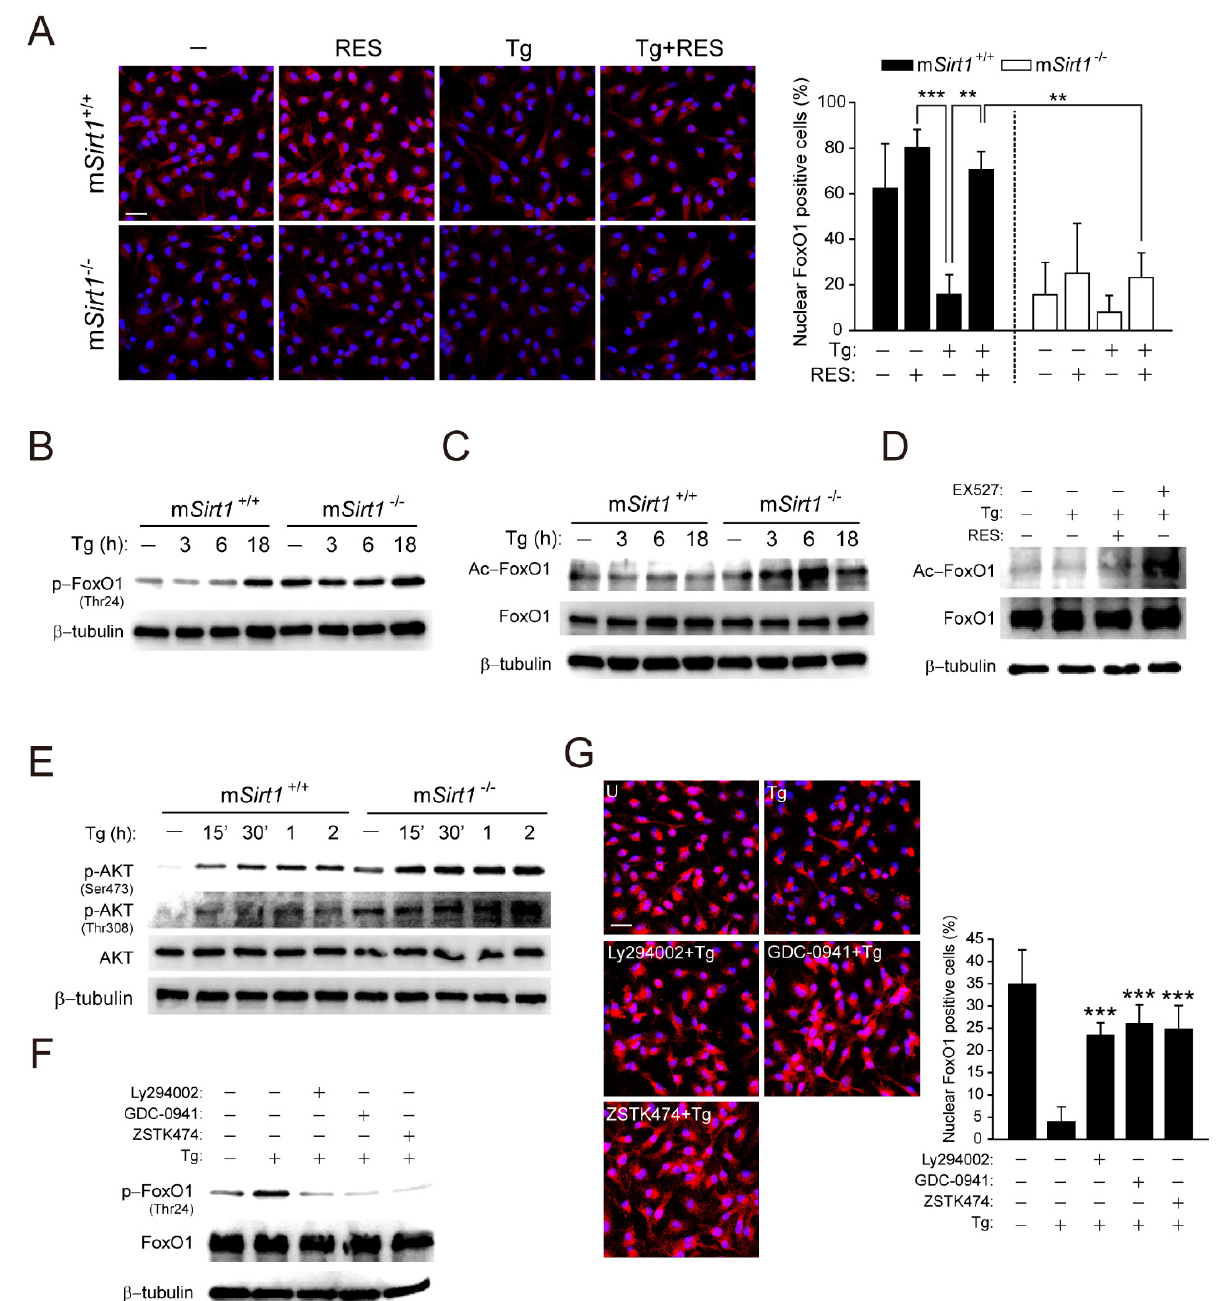
(Alexa Fluor 594-conjugated goat anti-rabbit IgG, red) and the level of colocalisation T. gondii with LC3 was quantified. Scale bar = 10 µ m. ( E ) LC3 (Alexa Fluor 488-conjugated goat anti-rabbit IgG, green), Alexa Fluor 594-conjugated LAMP1 (red), and DAPI (blue) were detected by confocal microscopy. Immunofluorescence microscopy images were obtained from one representative of 3 independent samples, with each experiment containing a minimum of 50 cells scored in 7 random fields. Scale bar = 10 µ m. Data are representative of three independent experiments and are presented as means ± SD. * p < 0.05, ** p < 0.01, and *** p < 0.001, compared with control cells (two-tailed Student’s t -test). Tg, Toxoplasma gondii ; RES, resveratrol; 3-MA, 3-methyladenine; WM, wortmannin.